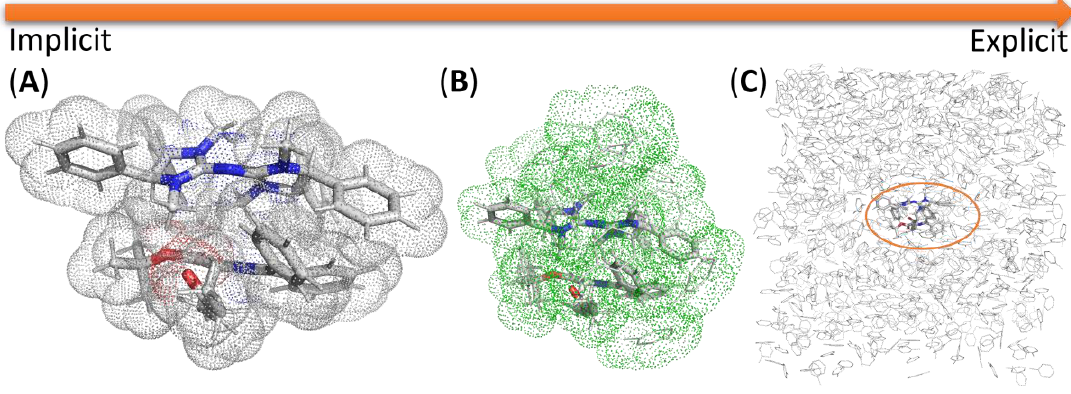
Figure 15. Various solvation models to apply to a PT catalyst that Tan and co-workers reported [146]. ( A ) Implicit solvation. Grey dots are SAS. ( B ) Hybrid approach. Solvent molecules (Toluenes) are displayed as wire. The green dots are the SAS. ( C ) Explicit solvation in a 5.6 nm cube. The catalyst is in the orange oval.